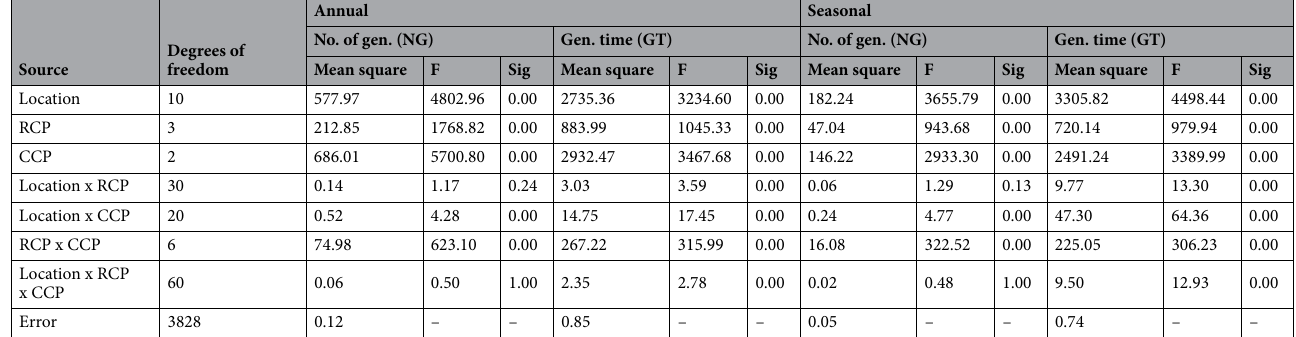
Table 1. ANOVA of number of generations and generation time (Annual/Seasonal) of H armigera across 11 Locations, 4 RCPS and 3